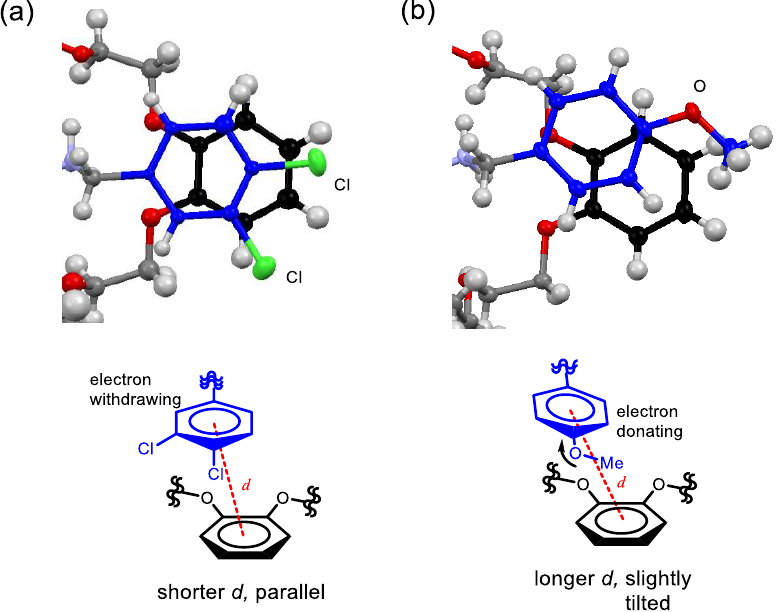
Figure 4. Partial structures of pseudorotaxanes ( a ) 1a (left) and ( b ) 1j (right). Two close aromatic rings by crystallographic results and their schematic diagram are shown.